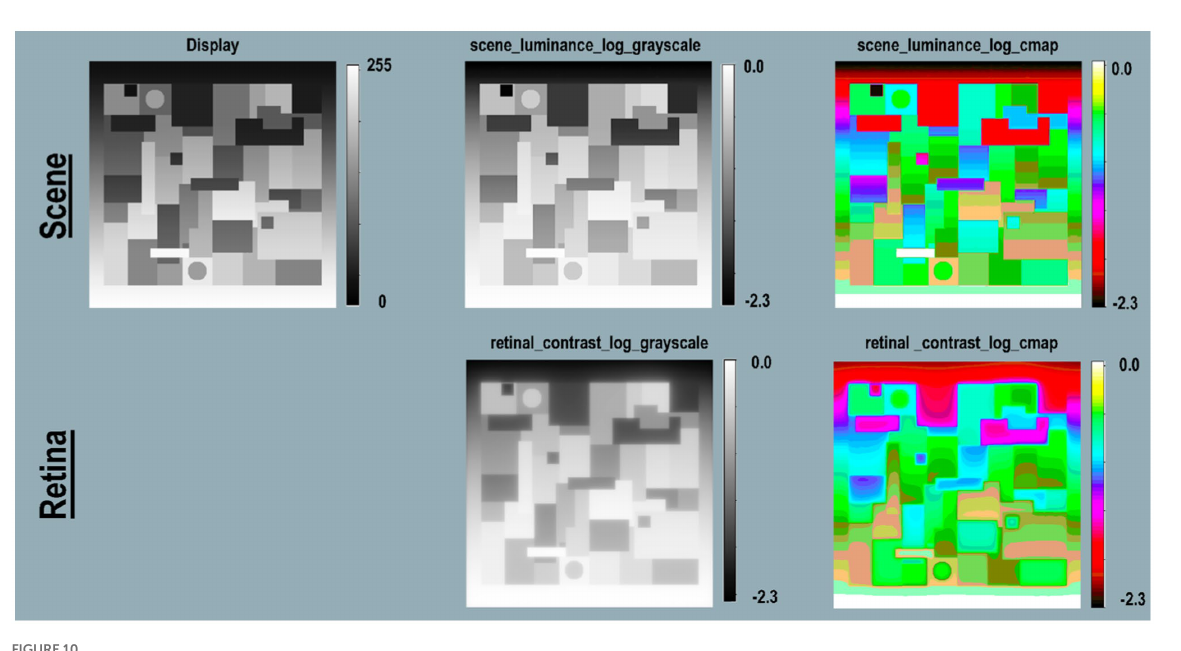
FIGURE 10 Land’s B&W Mondrian. Scene (top-row) Mondrian on display; scene_luminance _log_grayscale, and scene_luminance_log_cmap. Retina (bottom-row) retinal_contrast using same LUTs. All Figure 11 calculations used parameters [ log_range = 2.3 ], [ padding = replicate